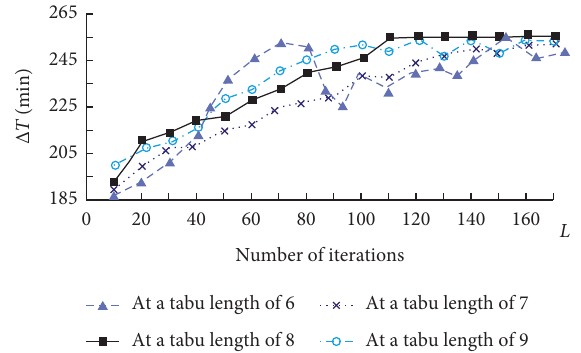
Figure 3: Schematic diagram of the iterative process of the ob- jective function value.